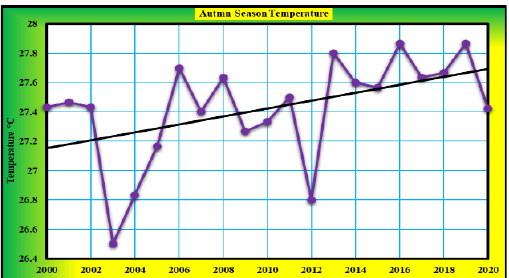
Figure 16: Summer Temperature Deviation in Ghotki district 2000-2020